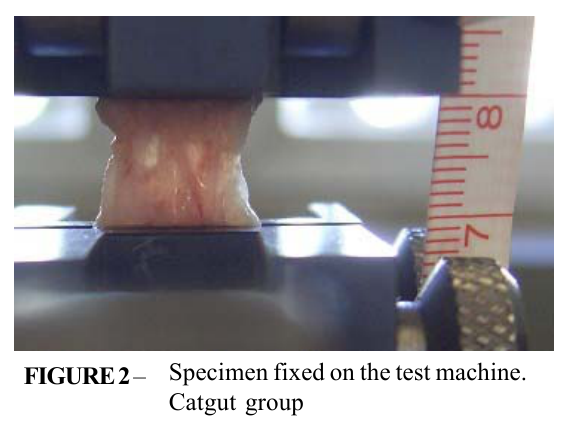
FIGURE 2 – Specimen fixed on the test machine. Catgut group